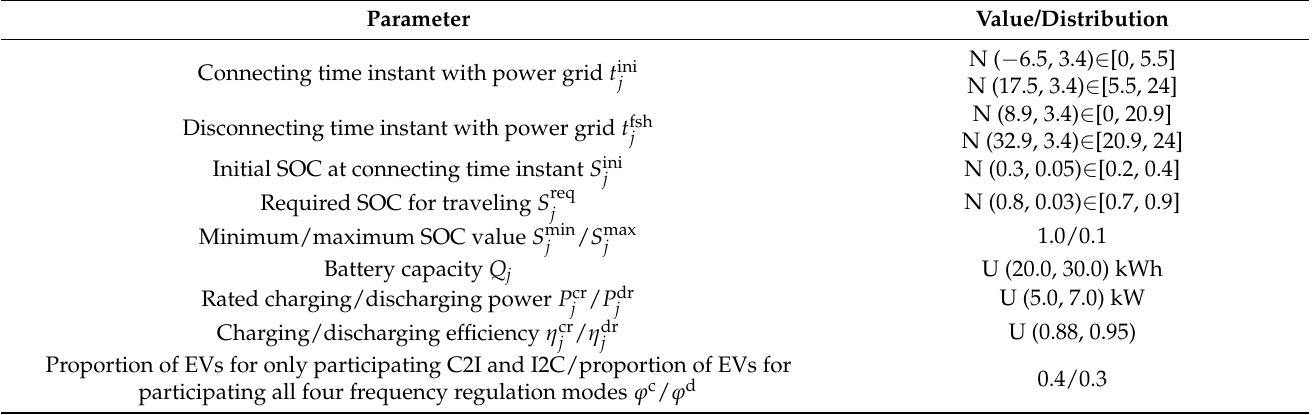
Table 2. Time, energy, and preference parameters of aggregated